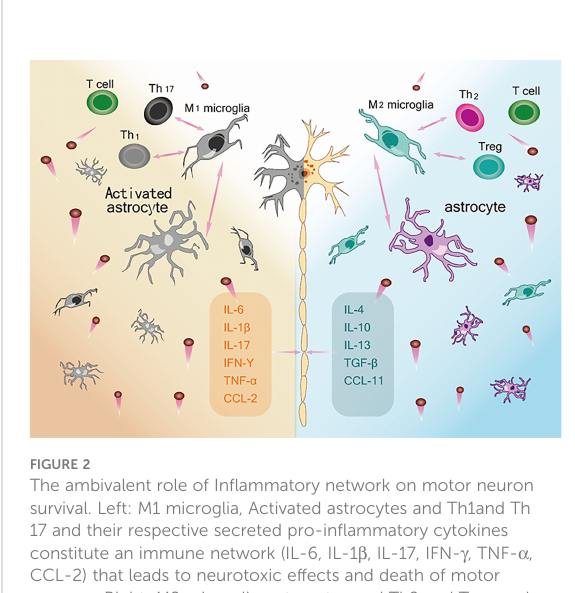
FIGURE 2 The ambivalent role of In fl ammatory network on motor neuron survival. Left: M1 microglia, Activated astrocytes and Th1and Th 17 and their respective secreted pro-in fl ammatory cytokines constitute an immune network (IL-6, IL-1 b , IL-17, IFN- g , TNF- a , CCL-2) that leads to neurotoxic effects and death of motor neurons. Right: M2 microglia, astrocytes and Th2 and Treg and their respective release of anti-in fl ammatory and neurotrophic factors (IL-4, IL-10, IL-13, TNF- b , CCL-11) constitute an immune network that supports the function and activity of